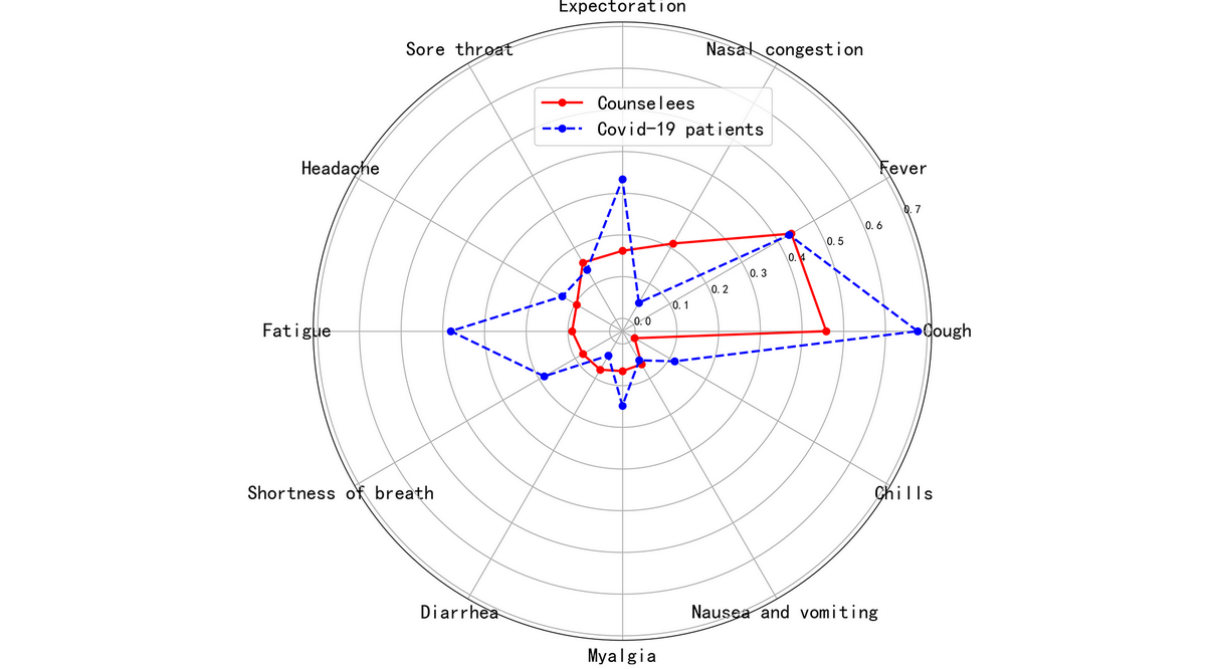
Offline visit recommendation, n (%)Offline visit motivation, n (%)Hypochondriacal suspicion, n (%)Counselee type